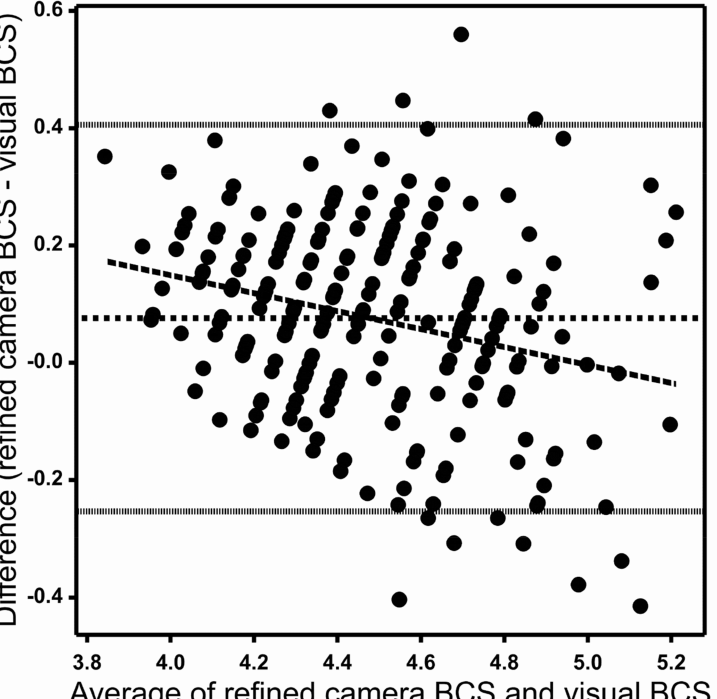
Figure 4. Bland–Altman plot with each solid dot representing a weekly mean body condition score (BCS) for a cow between refined camera and visual measurement methods. The central horizontal dotted line represents the mean difference between the two measurement methods, and the fine dotted lines represent the 95% range of the differences. The long-dashed line is a linear regression ( p < 0.05) of difference versus the